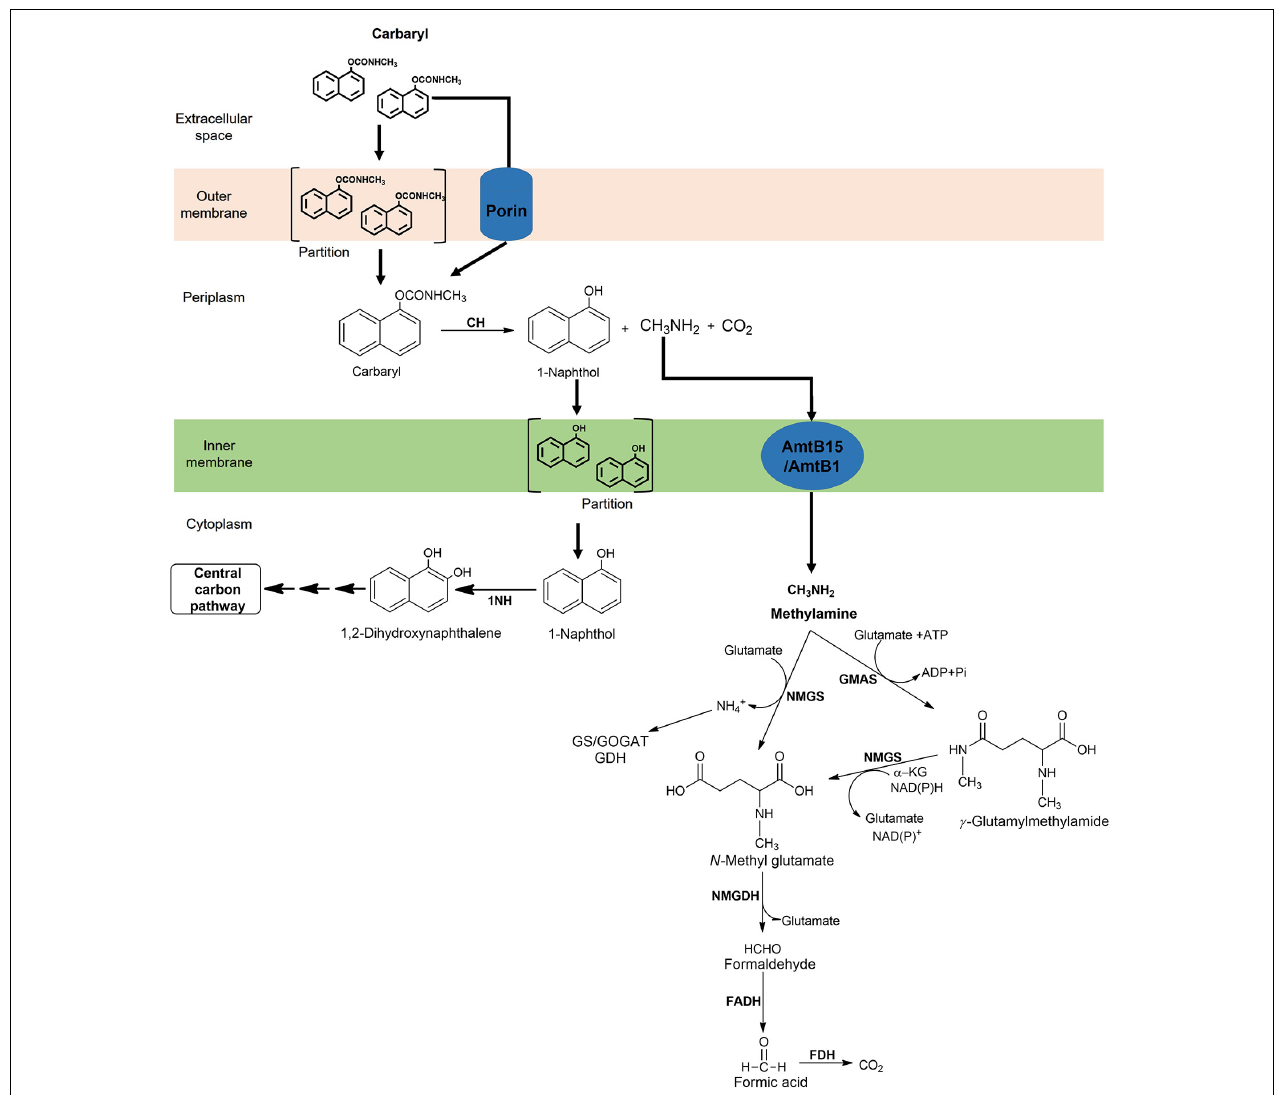
FIGURE 11 | Compartmentalisation of Carbaryl degradation and methylamine metabolic pathway in Pseudomonas sp.